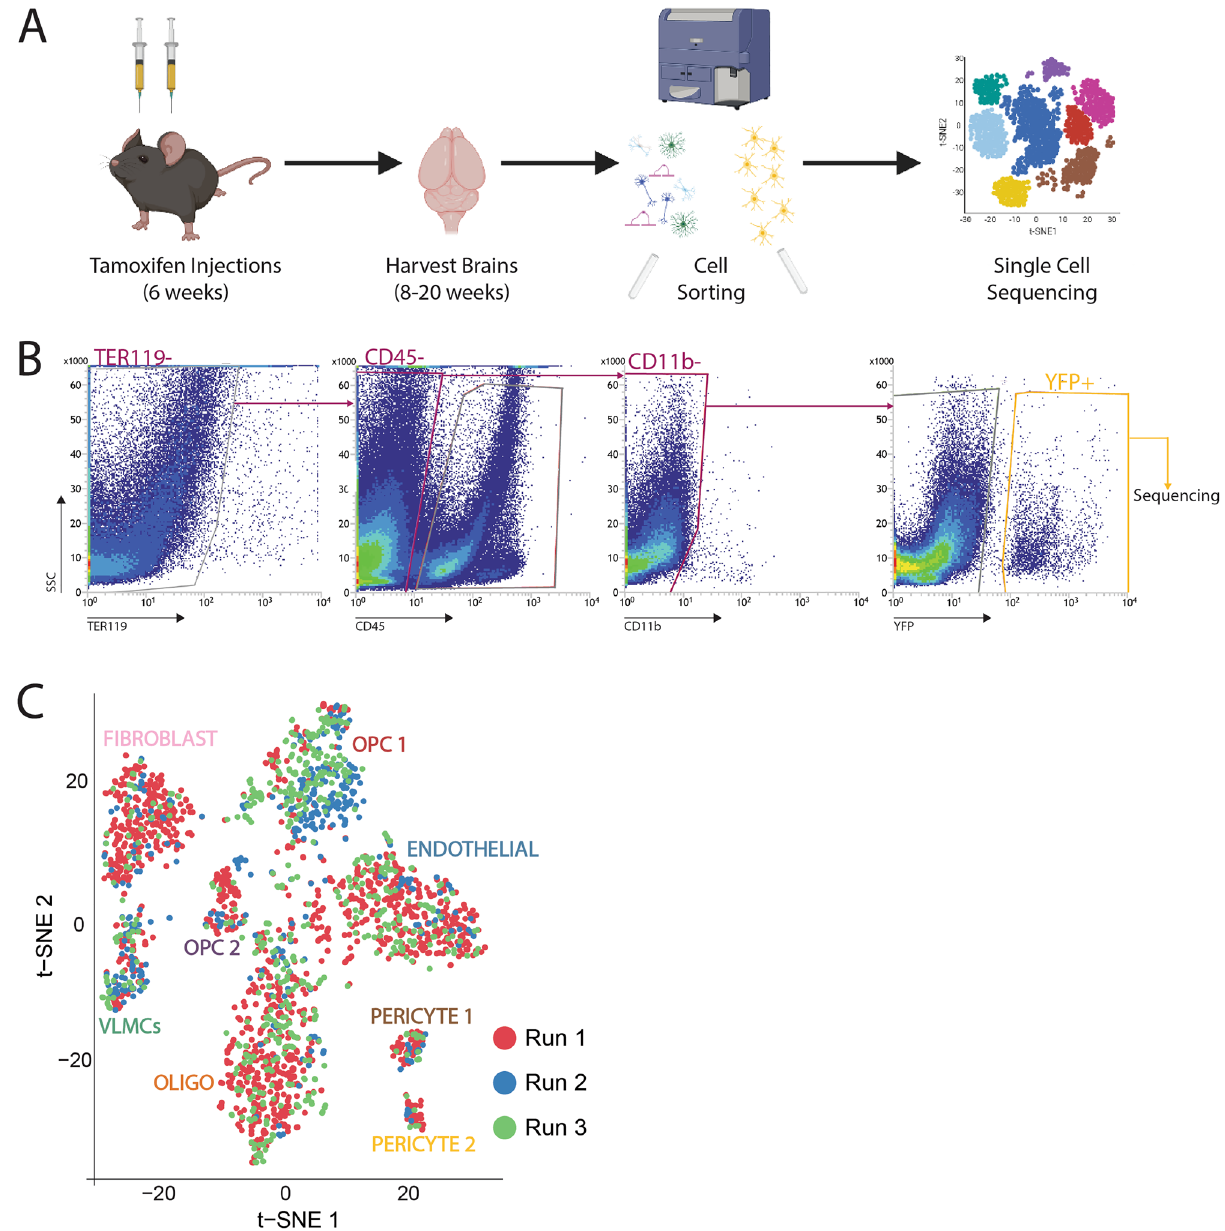
Figure 2. Isolation of YFP+ cells from PDGFRα-Cre ER × YFP brains for sequencing. ( A ) Experimental strategy used for the isolation and single-cell sequencing of cells. ( B ) Gating strategy for YFP+ cell sorting following live/ scatter/singlet gating. ( C ) tSNE map depicting cell clusters colored by sequencing